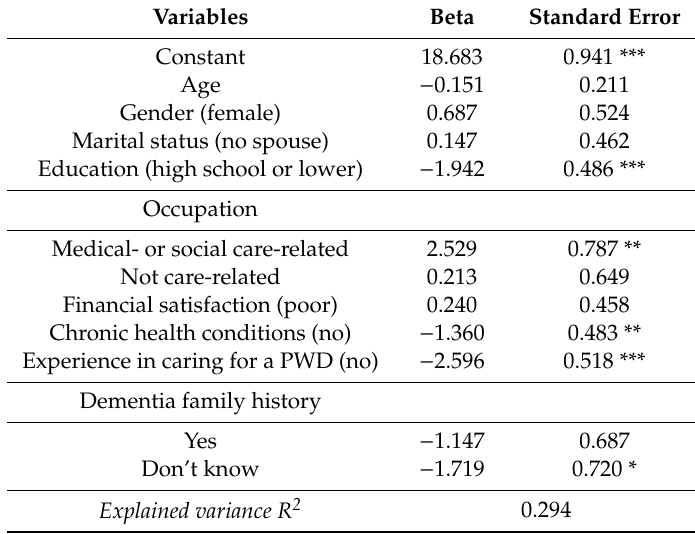
Table 2. Factors related to knowledge about dementia by multivariate linear regression.